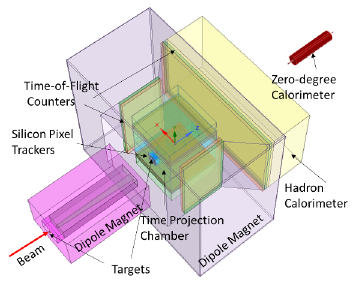
Figure 6. Schematic view of the proposed spectrometer in phase